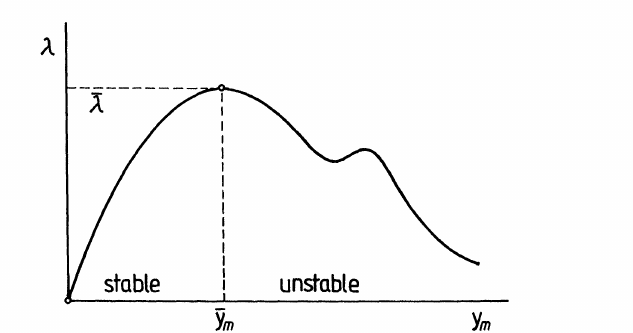
FIGURE 9(a) The bifurcation diagram for entirely convex functions w(y), with the stable branch of A(Ym) bounded by a supremum-maximum X.